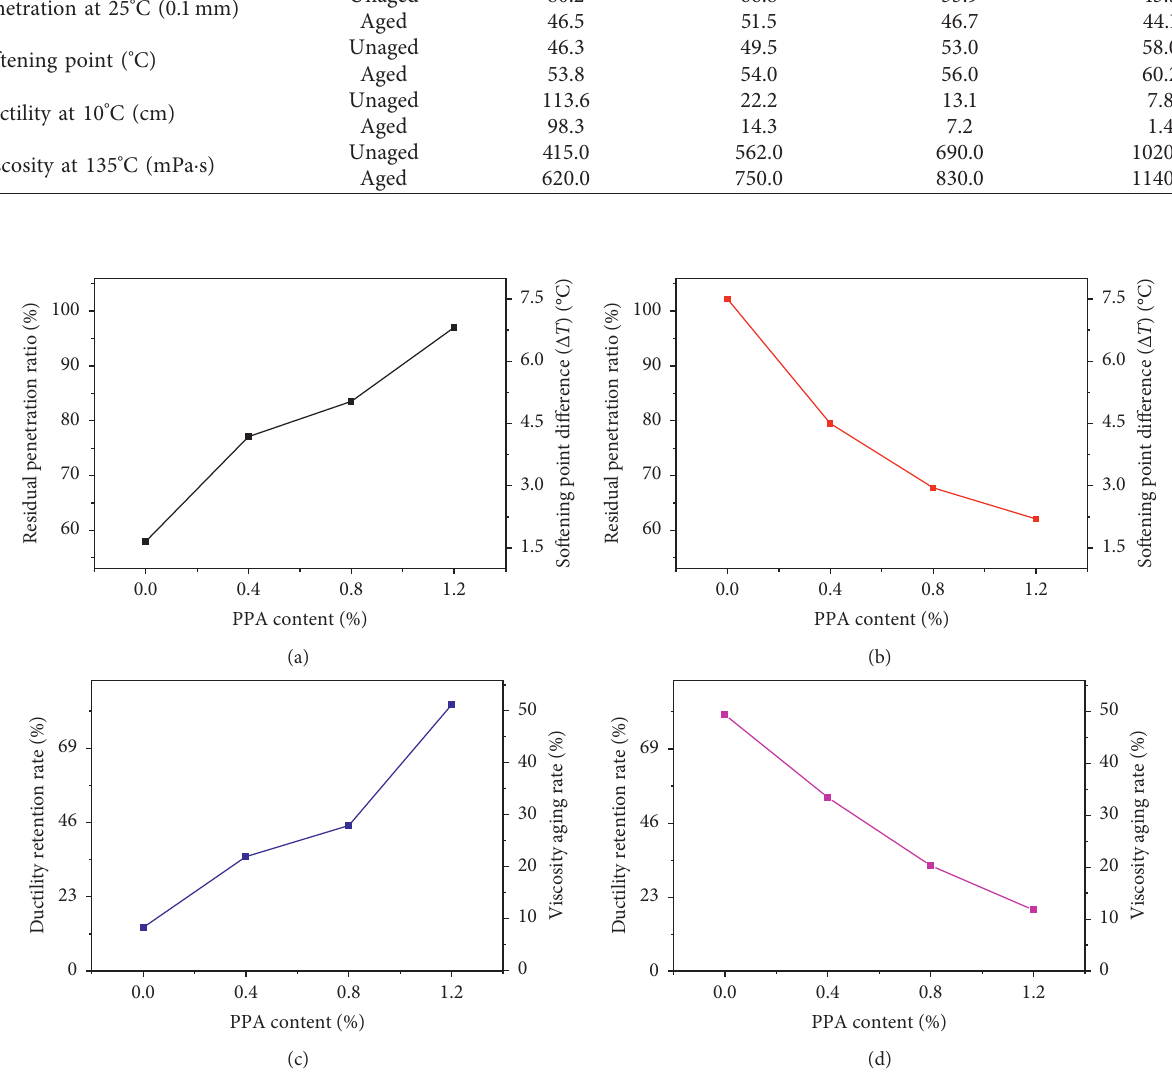
Figure 5: Effect of PPA content on (a) RPR, (b) Δ T , (c) DRR, and (d) VAR.